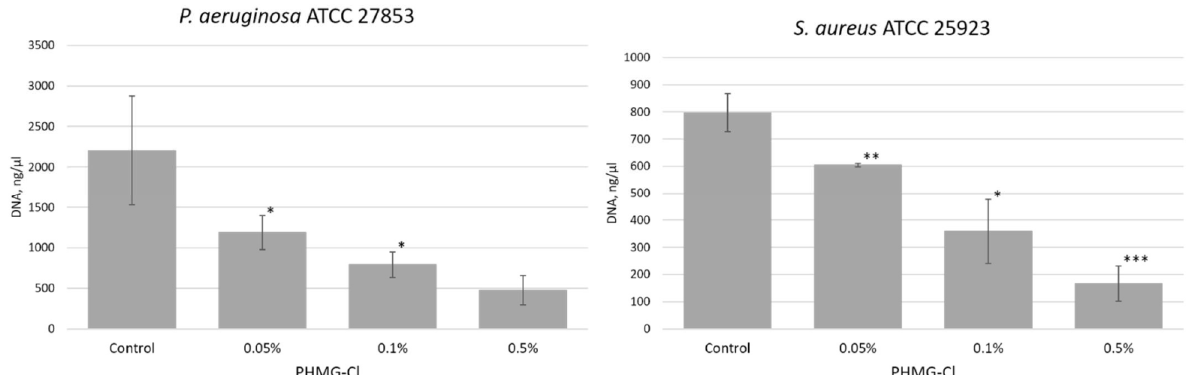
Figure 5. Increasing concentrations of PHMG-Cl reduce eDNA yield from Pseudomonas aeruginosa ATCC 27853 (PA) and Staphylococcus aureus ATCC 25923 (SA) biofilms. Shown here is the eDNA yield from 3-day old PA ( left ) and SA ( right ) biofilms after treatment with PHMG-Cl ( n = 3). Statistical differences are determined between treatments and the water-treated positive controls for each of the PA and SA biofilms; * p < 0.05, ** p < 0.01, and *** p <